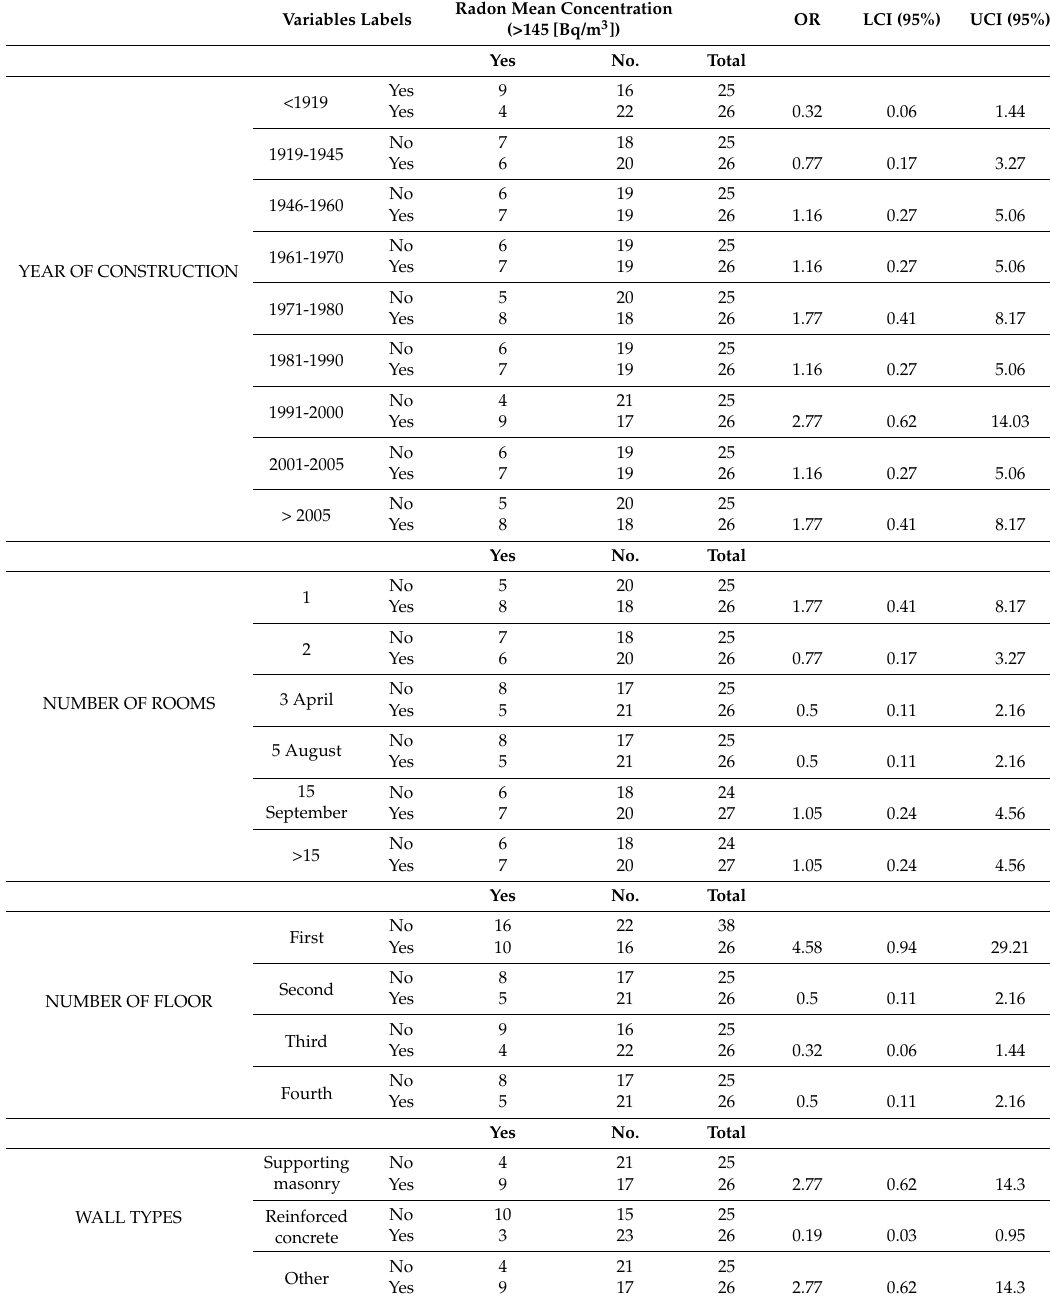
Table 1. Risk (ORs) distribution to observe Radon high mean concentrations (>145 Bq/m 3 ) by multiple determinant factors. Radon Mean Concentration OR LCI Variables Labels (>145 [Bq/m 3 ])